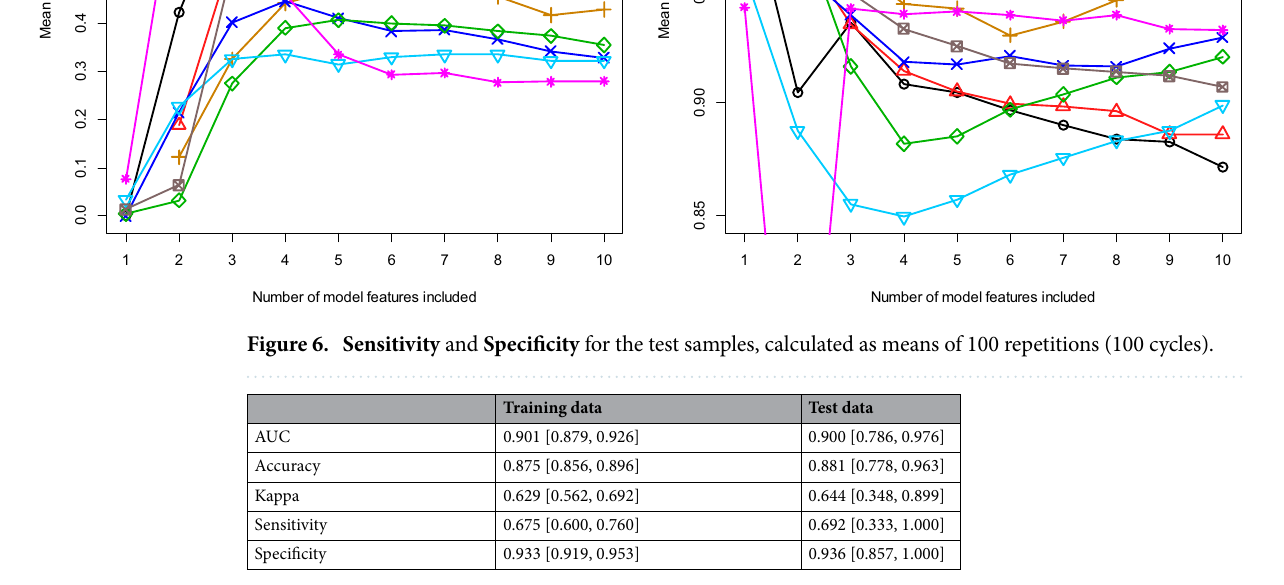
Table 3. Classification results of the logistic regression model with three features for training data and independent test data, calculated as means of 100 repetitions (100 cycles). Values in brackets: 95% confidence